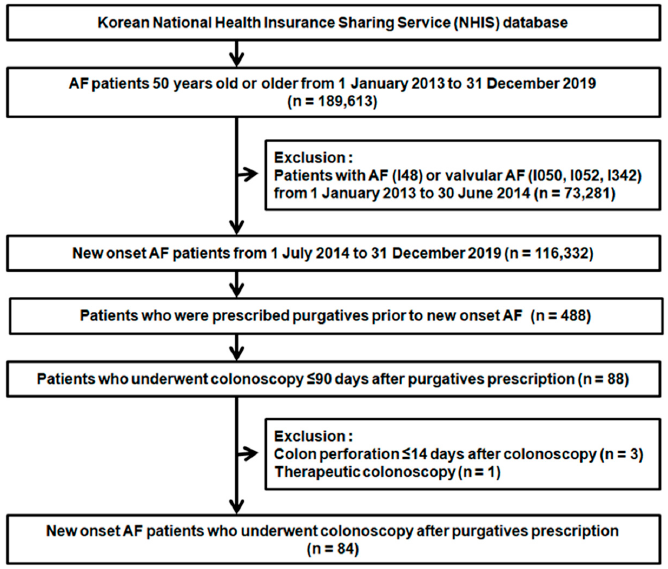
Figure 2. Flow diagram of the study population. AF, atrial fibrillation.